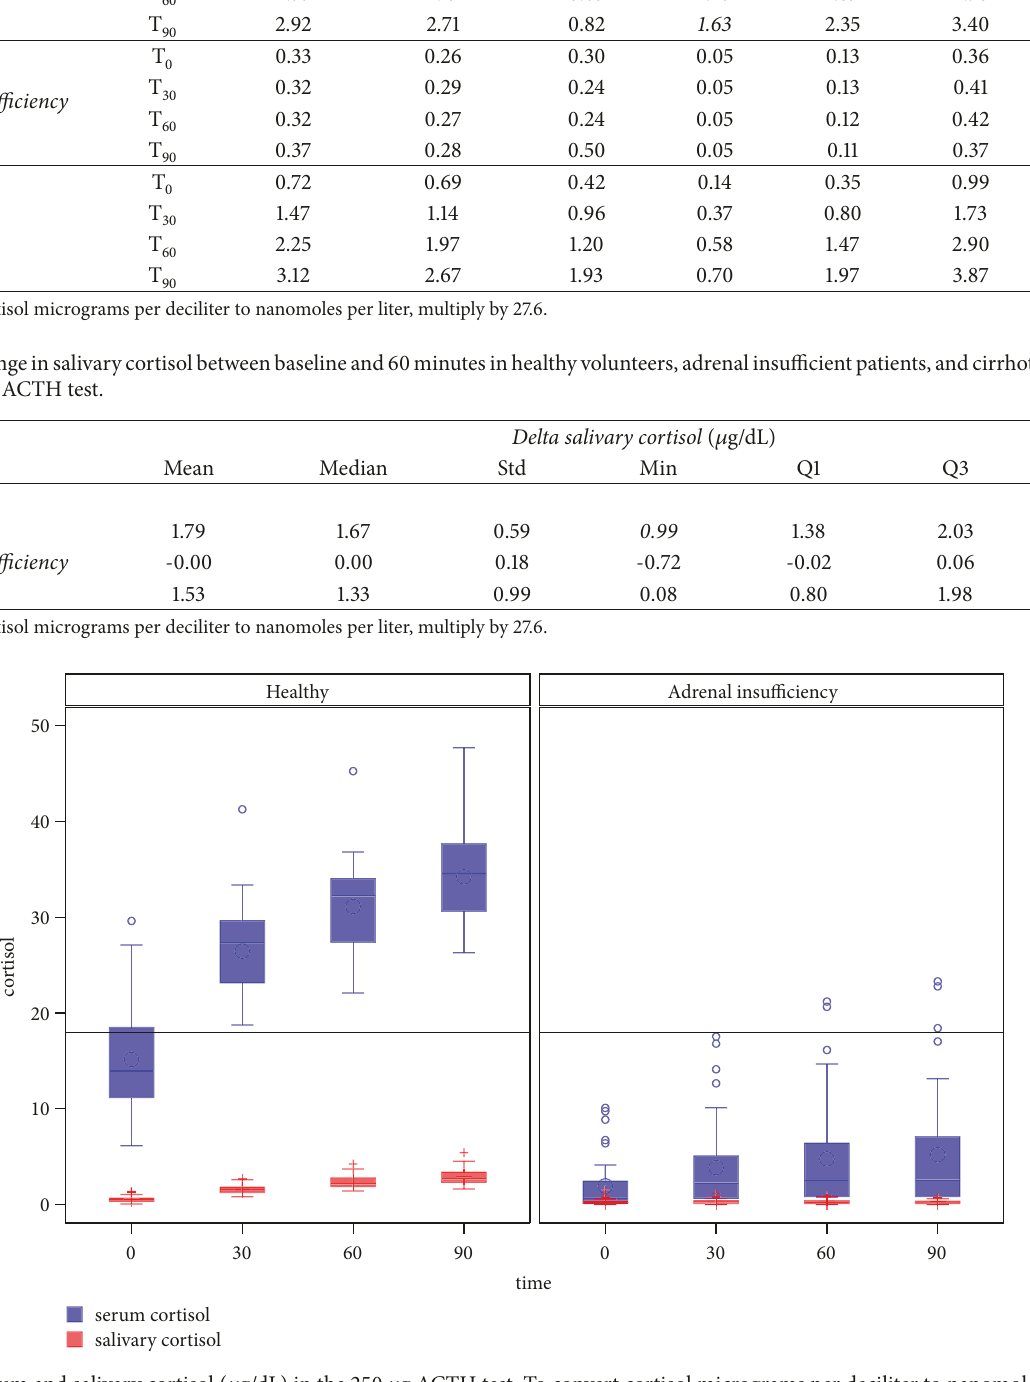
Figure 1: Serum and salivary cortisol ( 𝜇 g/dL) in the 250 𝜇 g ACTH test. To convert cortisol micrograms per deciliter to nanomoles per liter, multiply by